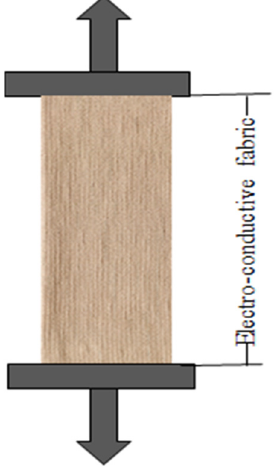
Figure 2. Experimental setup to measure the resistances and unidirectional tensile force.